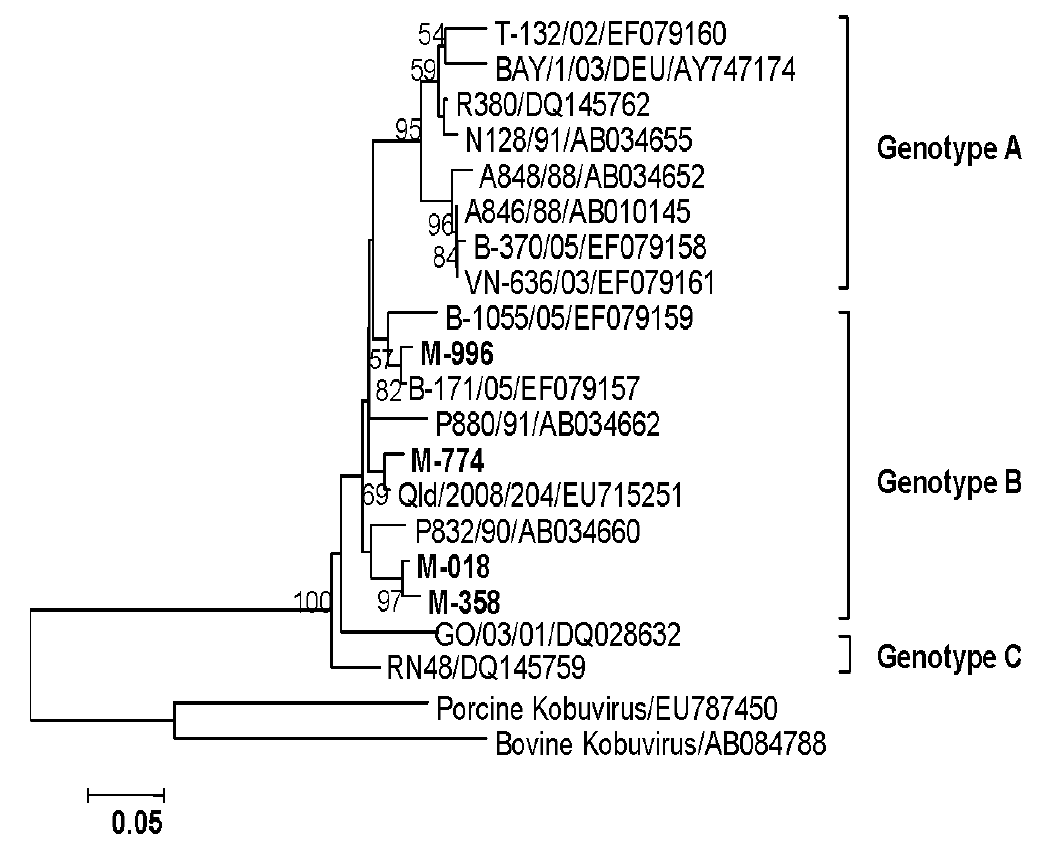
Figure 8. Phylogenetic tree based on the partial nucleotide sequences of 3C-3D junction region (185 bp) of AiV strains. The strains of the present study are in bold face. Scale indicates genetic